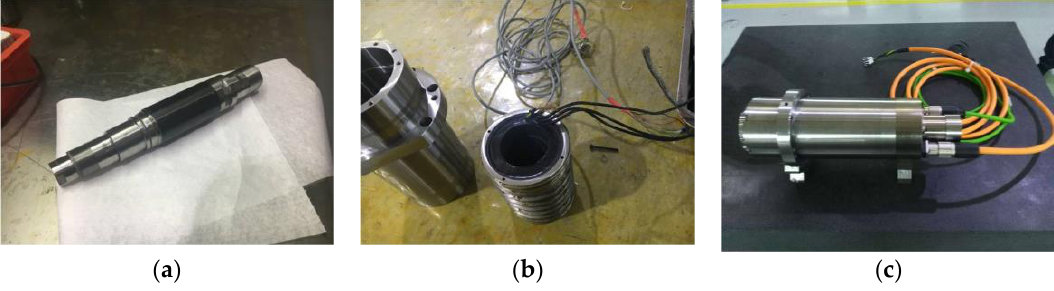
Figure 11. ( a ) The rotor with carbon fiber sleeve; ( b ) The appearance of stator; ( c ) The appearance of the prototype motor.